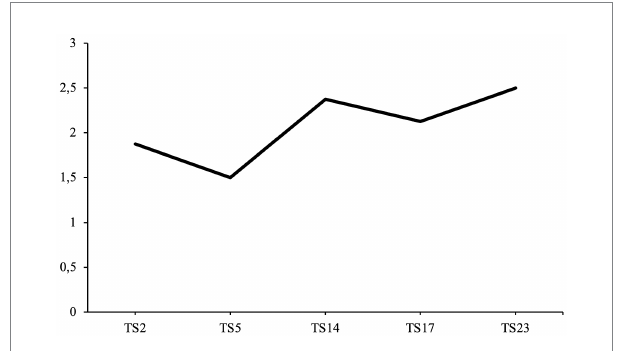
FIGURE 6 Average coherence scores over the course of treatment. TS, therapy